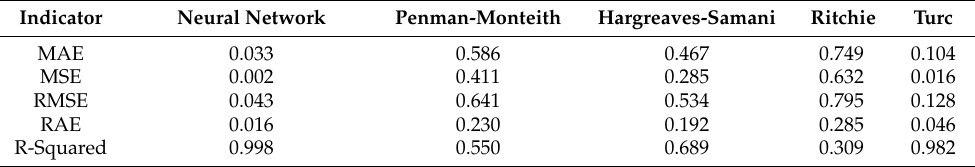
Table 2. Metrics results.